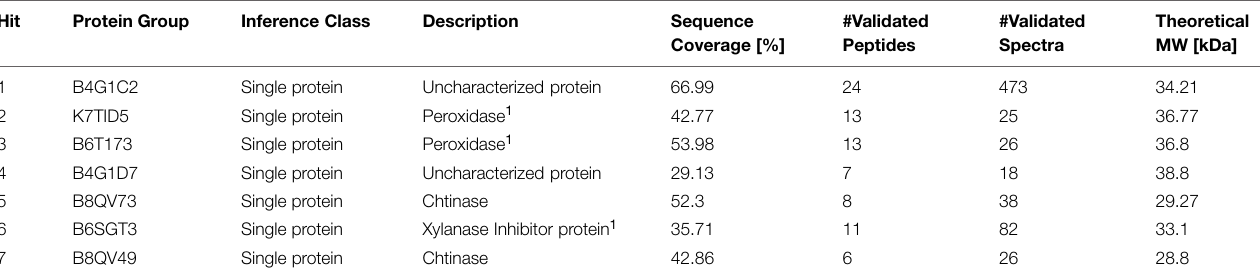
FIGURE 2 | Purification of protein with POD activity from p84C3 maize kernels. (A) Coomassie R-250 staining of the POD fractions of the different purification steps. (B) Sequential staining of POD fractions (guaiacol-H 2 O 2 + Coomassie R-250). (C) Guaiacol